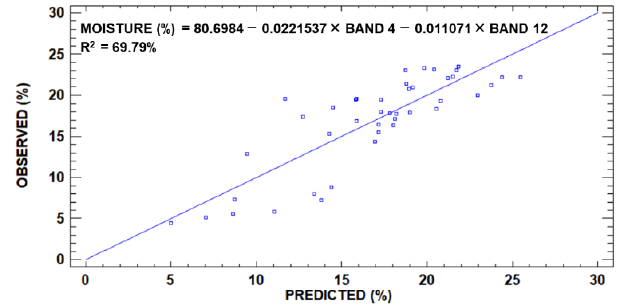
Figure 8. Multiple Regression Model for clay soil for bands with 20 m of resolution.